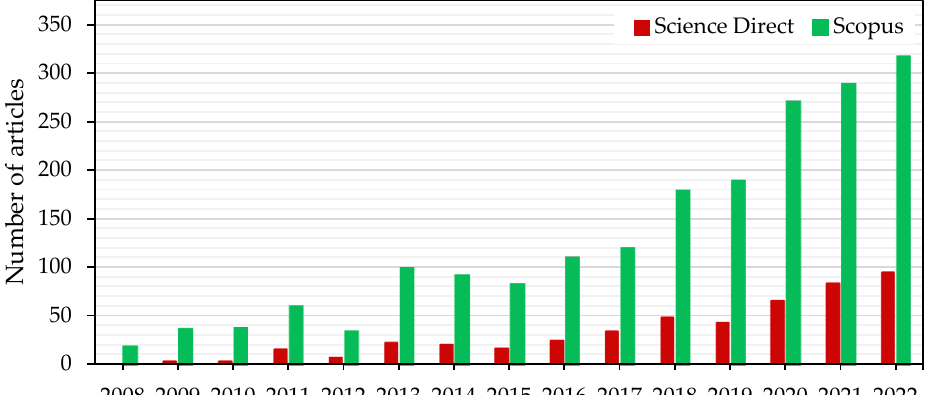
Figure 1. Evolution of research on concrete produced with CDW as recycled aggregates.